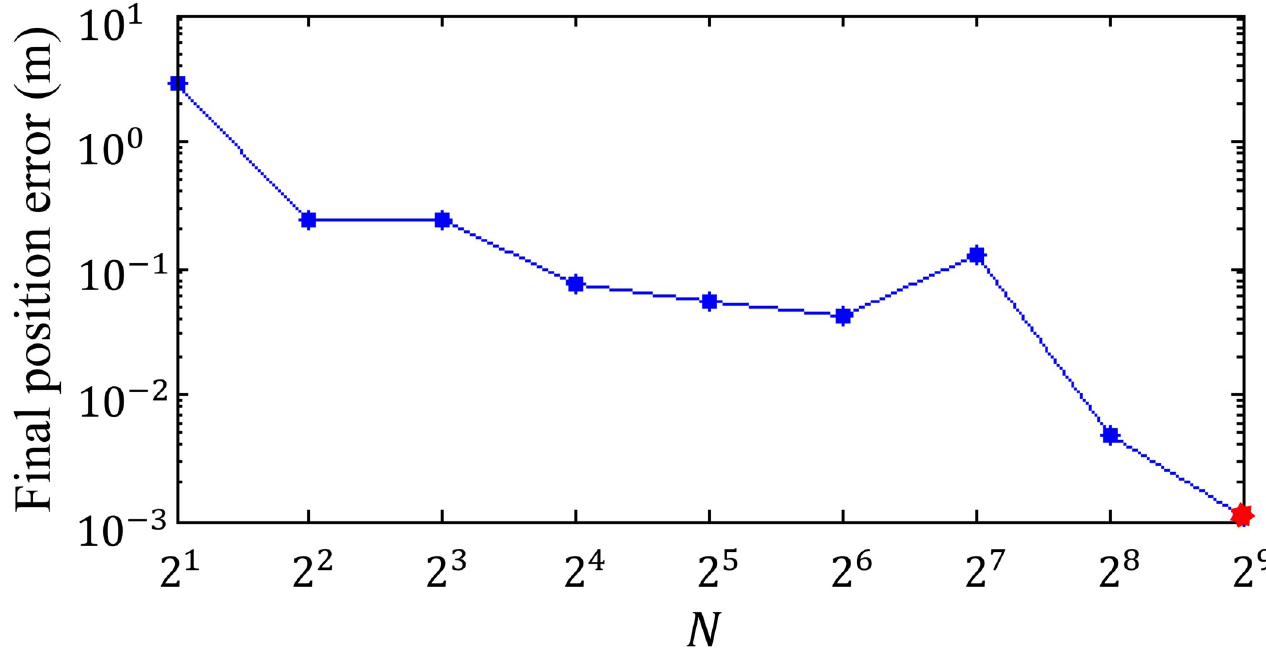
Fig 5. Final position error of the shield machine under different values of the penalty factor ( N